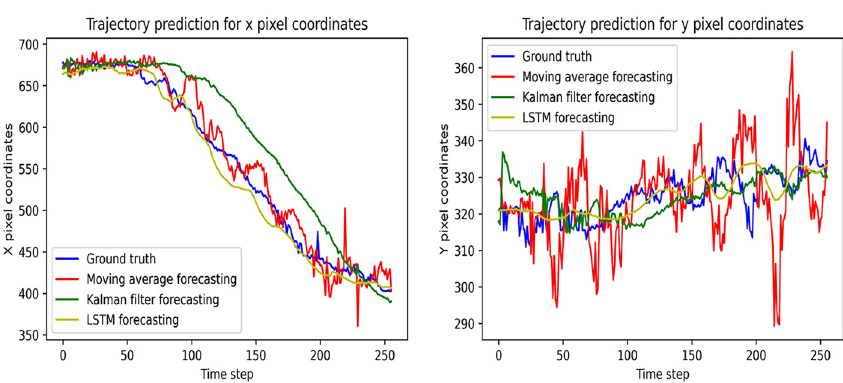
Figure 5 Trajectory prediction summary